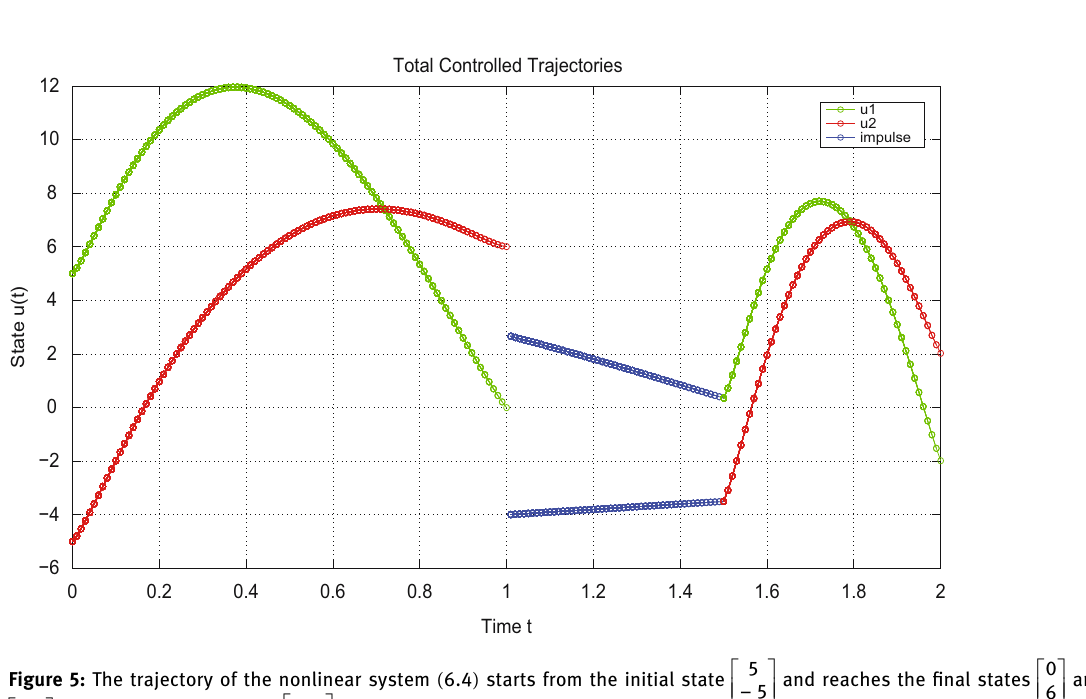
Figure 4: The trajectory of the impulsive nonlinear system ( 6.4 ) starts from the initial state 10   on 0, 2 [ ] state   − 10